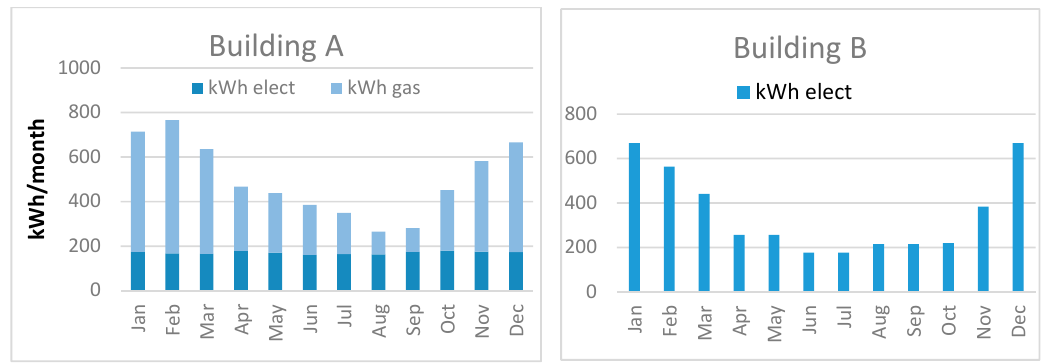
Figure 2. Average monthly energy consumption (kWh/month) in the average dwelling of the analysed buildings A ( left ) and B ( right ). Table 5. Average actual energy consumption and cost ratios of households in buildings A and B. Household Average Energy